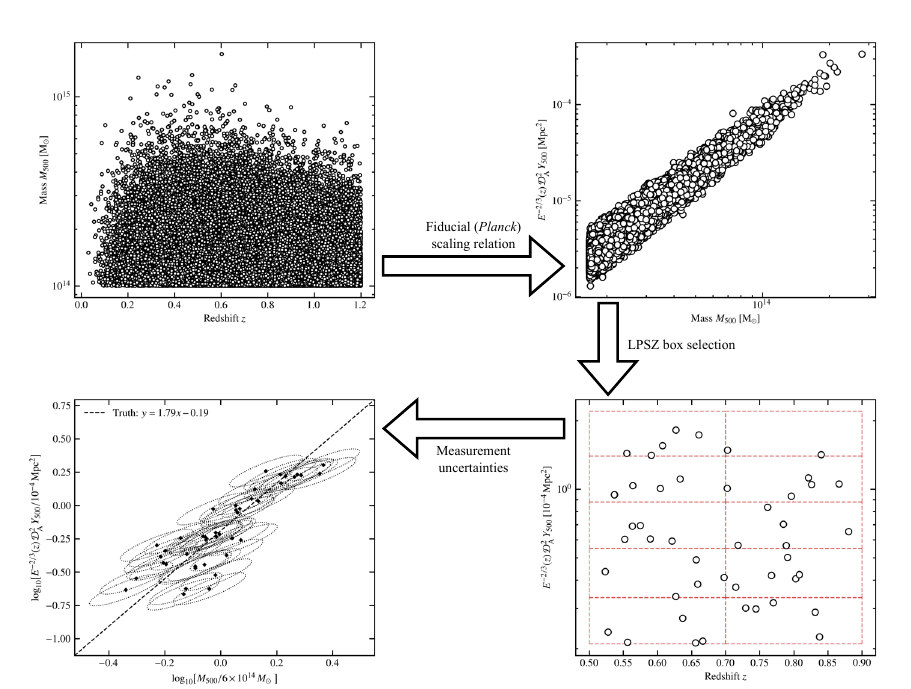
Figure 1. Schematic representation of the workflow used to generate a mock cluster sample. The produced samples mimic the NIKA2 LPSZ in terms of mass and redshift coverage, as well as data